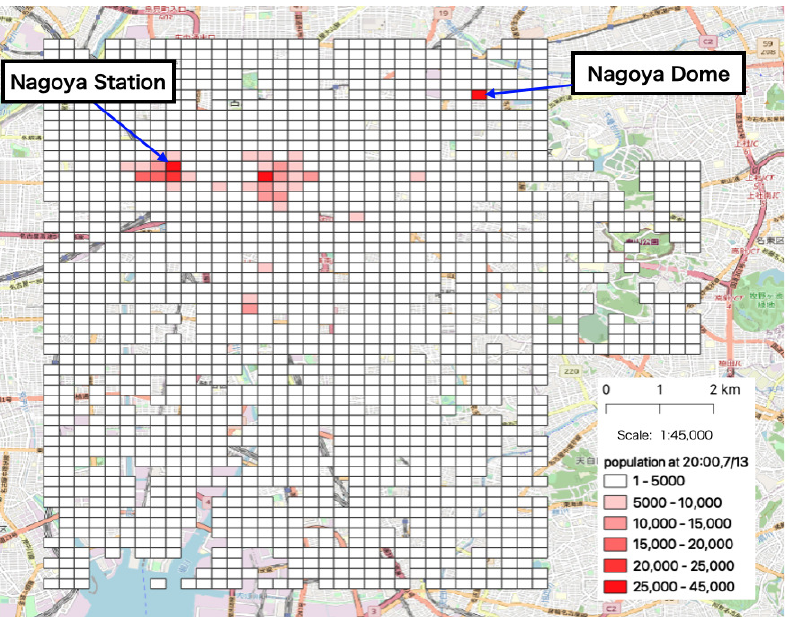
Figure 2. Visualization of the aggregated population data (13 July: